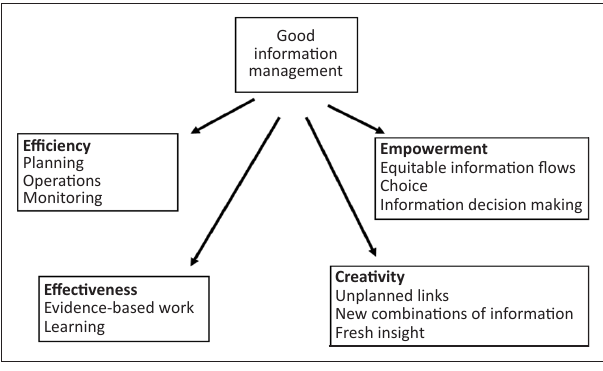
FIGURE 2: The core aims of information